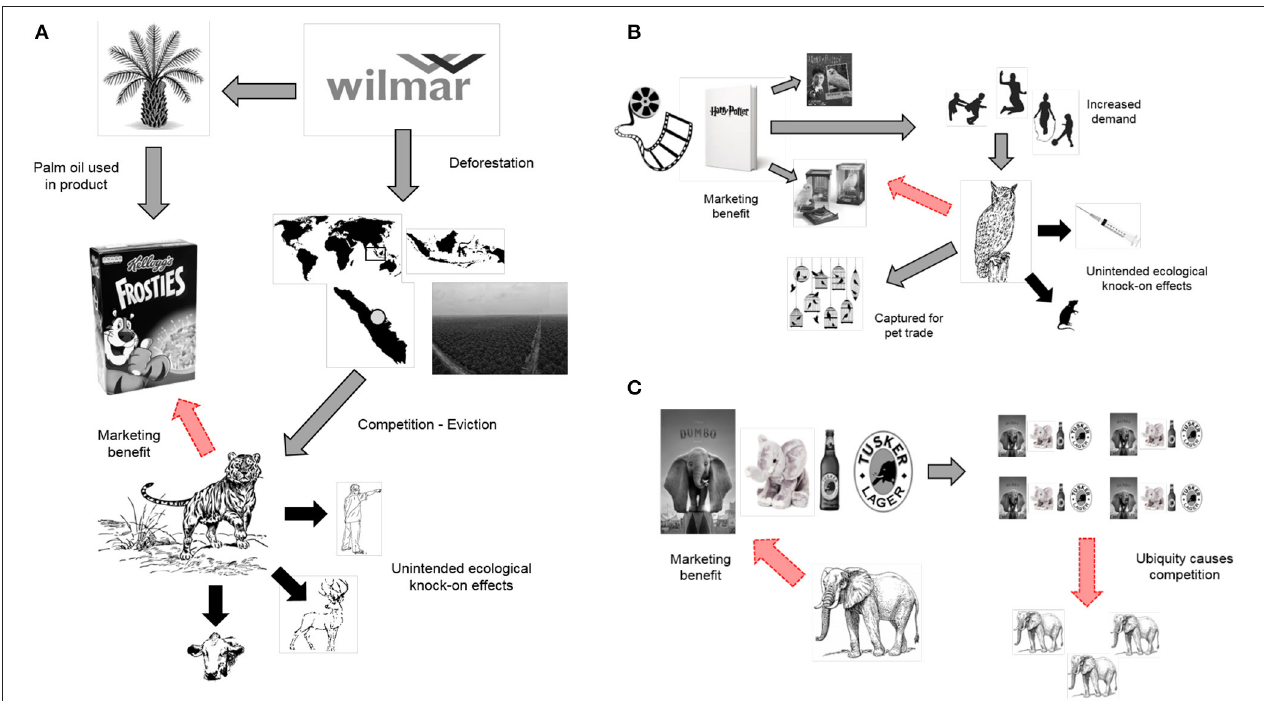
FIGURE 1 | Three examples of the mismatch between direct benefits accrued by companies in the use of threatened wildlife imagery and potentially negative effects exuded on those species by the companies. (A) This picture shows how the Kellogg’s Company purchases palm oil from the Wilmar Group. The palm oil is sourced from Riau, Sumatra (Indonesia)—locally important for both its forests and tiger populations. Wilmar has been linked to deforestation and unsustainable palm oil production. Deforestation reduces suitable habitat for tigers, causes intraspecific strife, and may have numerous cascading effects on tiger prey, conflict with people and their livestock. Kellogg’s uses tigers in their marketing campaigns and Tony the tiger has been the face of their Frosties cereal for over 65 years. (B) This figure shows an unintended effect caused by the dramatic rise in popularity of the Harry Potter franchise. Harry’s owl, and others seen in the film are believed to have increased the demand for pet owls by children in Malaysia. The franchise, characterized by the movies, books, and merchandise benefited from the use of owls, however, increased exploitation is likely to have placed pressure on these top-order avian predators. (C) Illustrates the competition of a virtual population of elephants (used on beer bottles, in the recent Dumbo film and plush toys) for public attention. Courchamp et al. (2018) showed that knowledge of in situ wildlife population species status in the public is being dumbed down by the ubiquity of these virtual